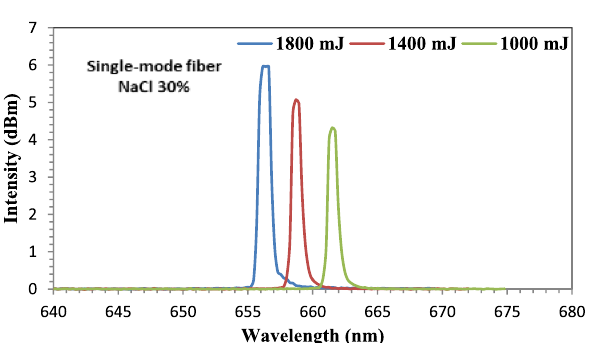
Figure 13. The output spectra of the fiber-optic immersed in NaCl solution at ablated energies of 1000, 1400, and 1800